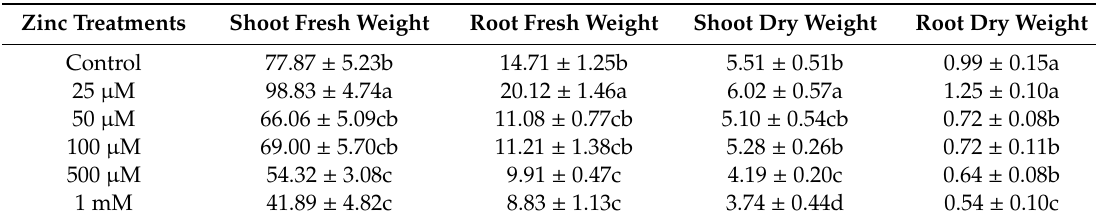
Table 1. E ff ect of long-term exposure to di ff erent zinc concentrations on the biomass of pak choi ( Brassica compestris ). Values are means ± SE ( n =